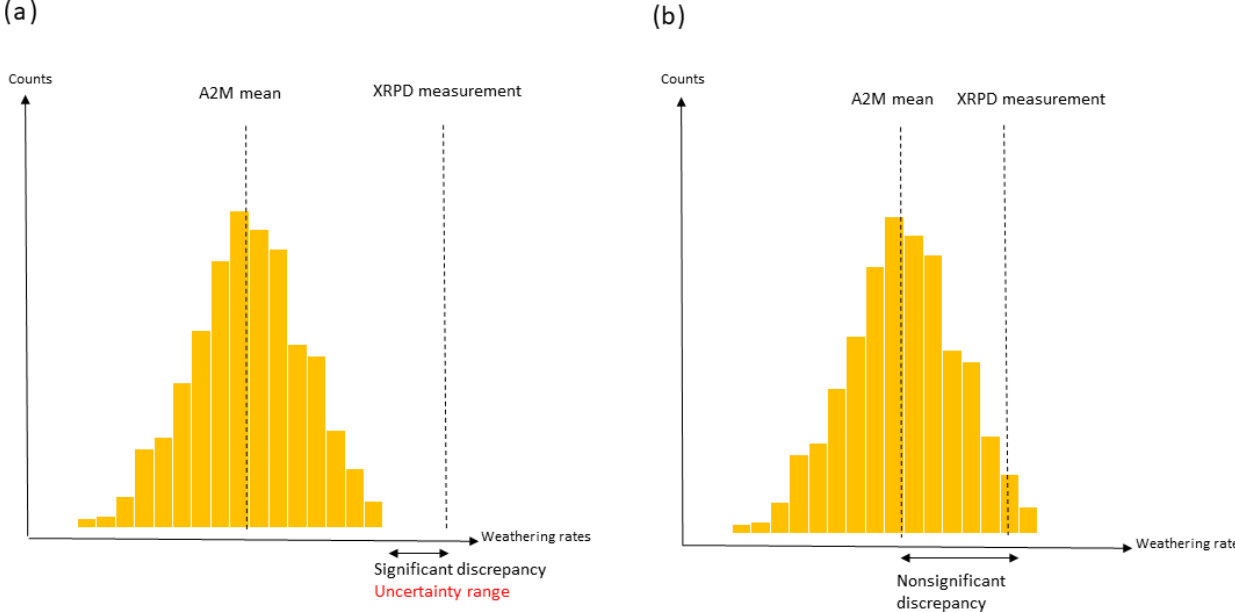
Figure 1. The first scenario for describing the effect of mineralogy on weathering rates in the upper mineral soil for a specific soil profile (a) happens when the PROFILE weathering rate based on XRPD (reference weathering rates) is not contained in the weathering range produced using PROFILE in combination with the full A2M solution space. There are two possible explanations of why a significant discrepancy introduces an uncertainty range, i.e., (1) due to uncertainties related to the mineralogical A2M input and (2) due to uncertainties related to the limitation of the XRPD method itself (i.e., detection limit). The second scenario (b) occurs when the reference weathering rate is contained in the full A2M weathering span. In this case we speak of “nonsignificant